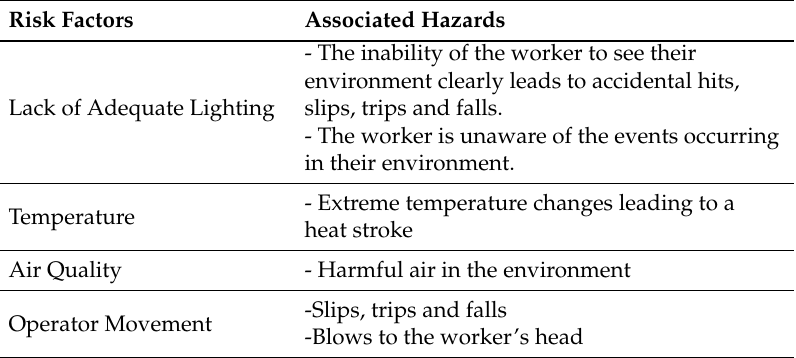
Table 5. Identification of common risk situations in the worker’s